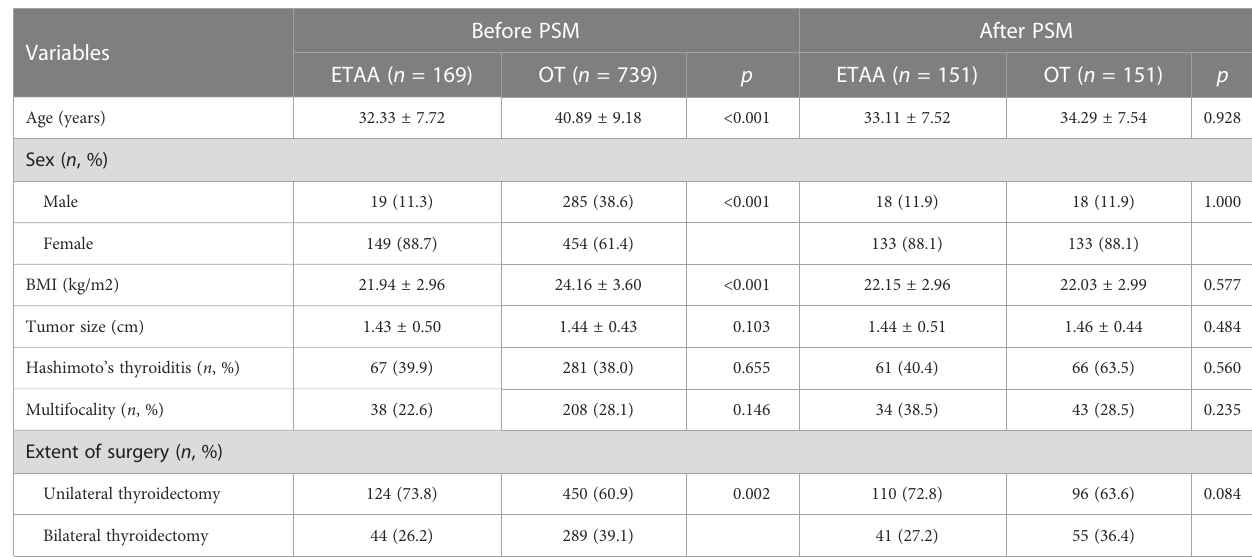
TABLE 1 Clinicopathologic